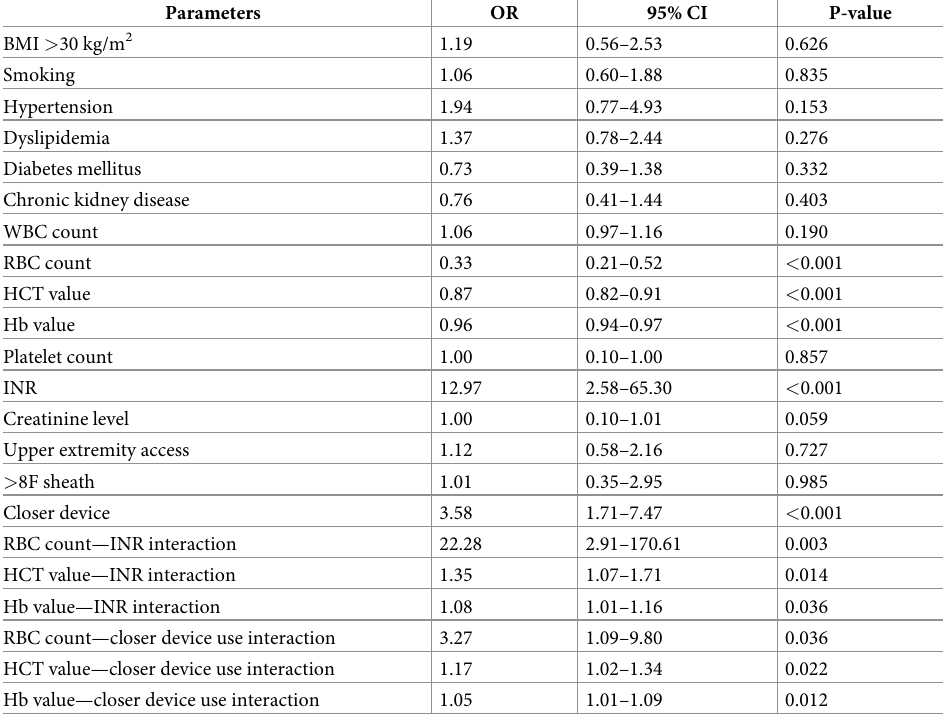
Table 5. Predictors of pseudoaneurysm formation.